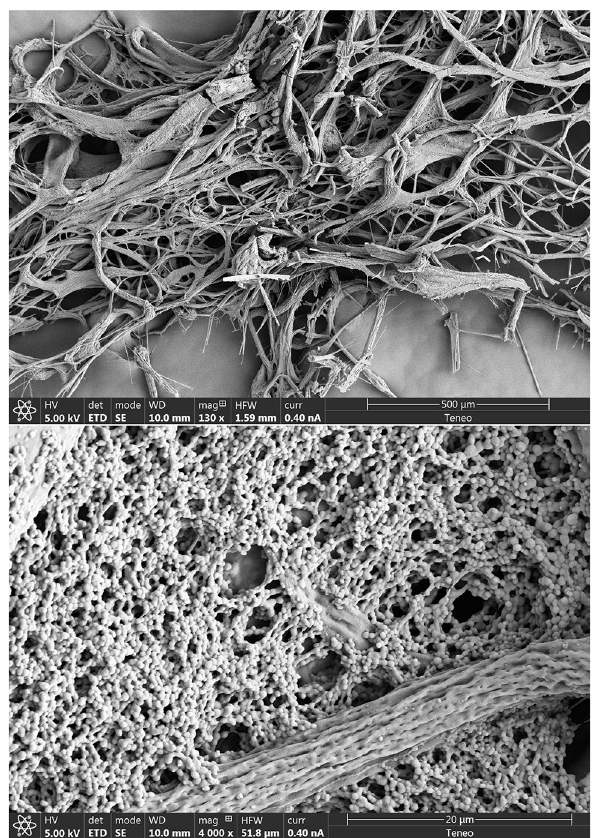
Figure 1. (Top panel) Result from experiment 1: the millimeter-scale appearance of the fibrous as-blown (non- stretched) material, without additional processing. Here, the absence of any additional mechanical input leaves a structure dominated by the inertia of the large scales. (Bottom panel): An illustration of the free-blowing structure of the material: the non-stretched globular structure, as described by 33 , is readily apparent together with a mildly stretched fiber that exhibits a typical micro-structure revealing its